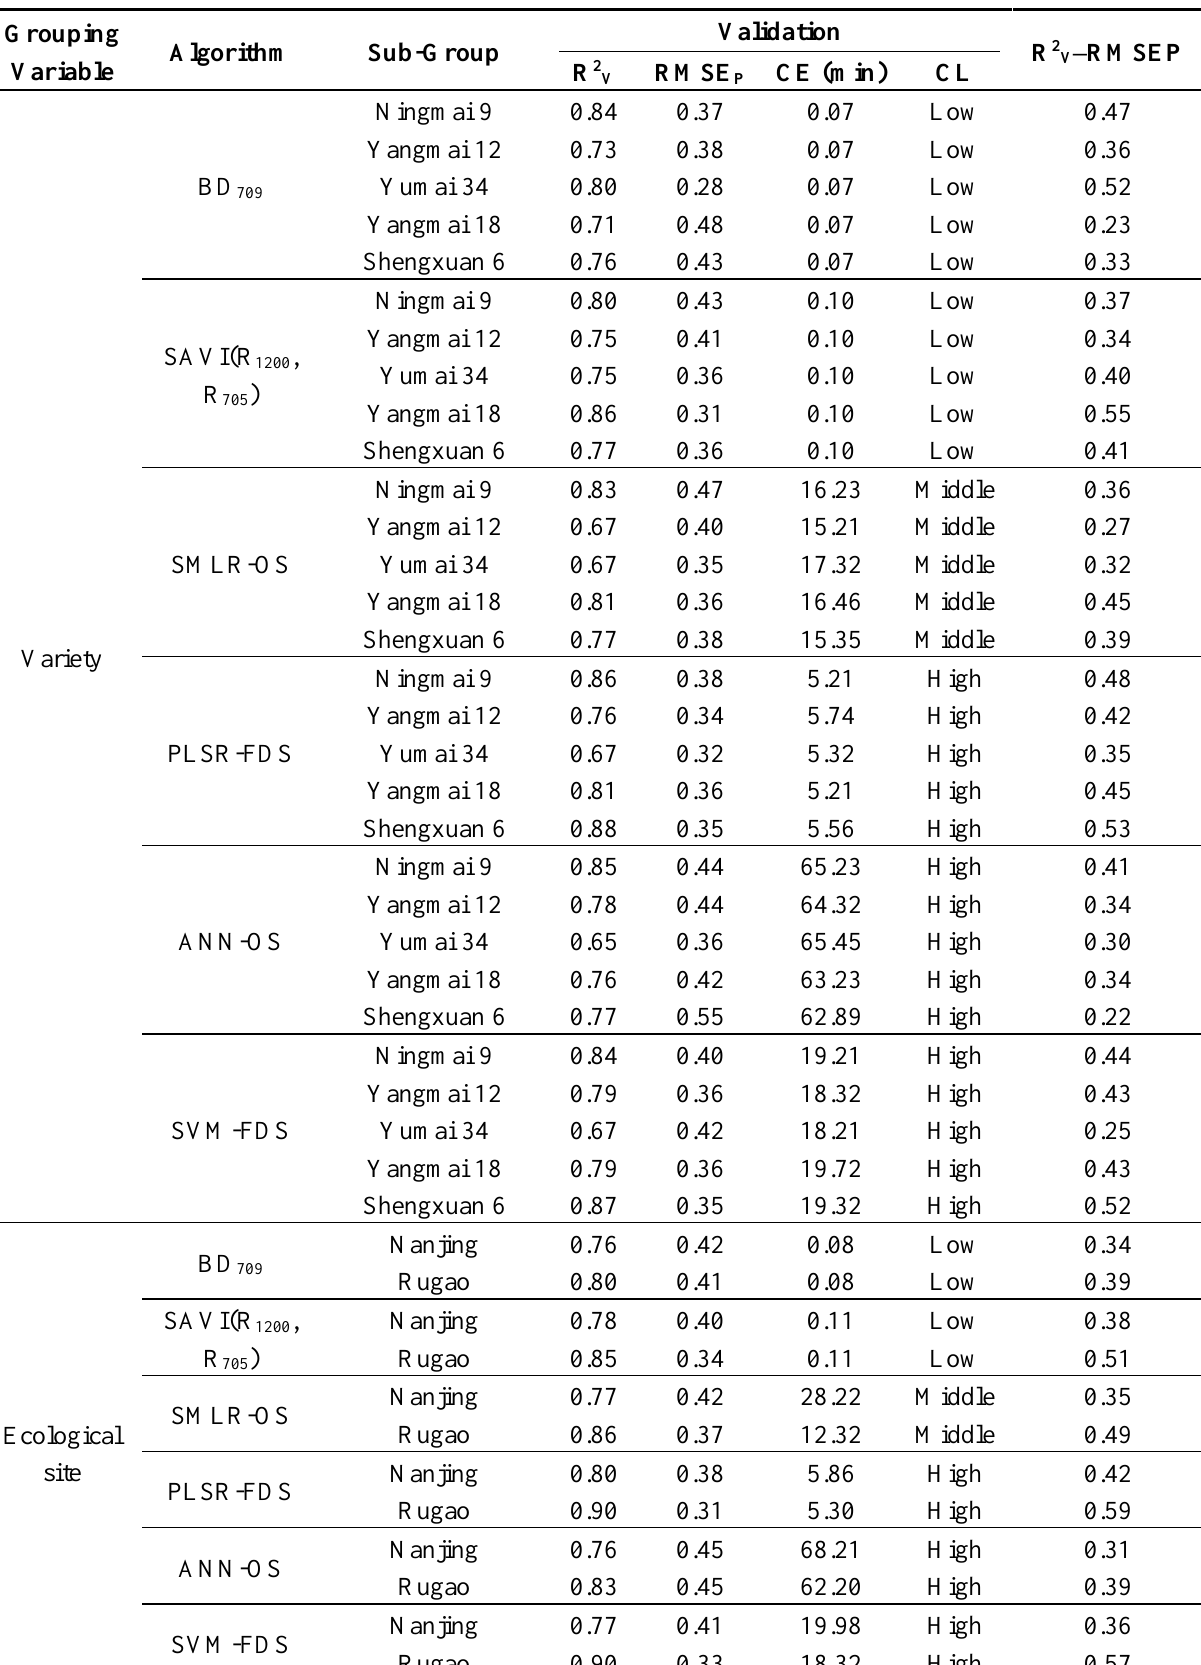
Table 10. Robustness of the LNC models based on the six algorithms when the samples are categorized using three grouping variables (variety, ecological site, and growth